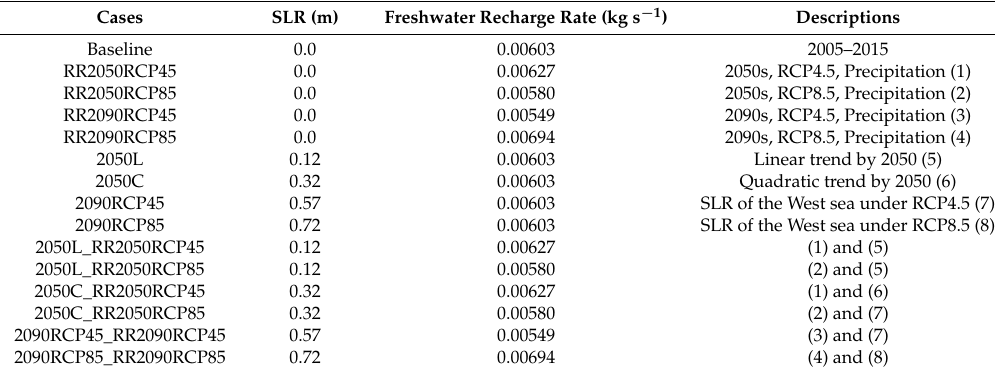
Table 1. Fifteen scenarios, including the baseline with SLR and freshwater recharge